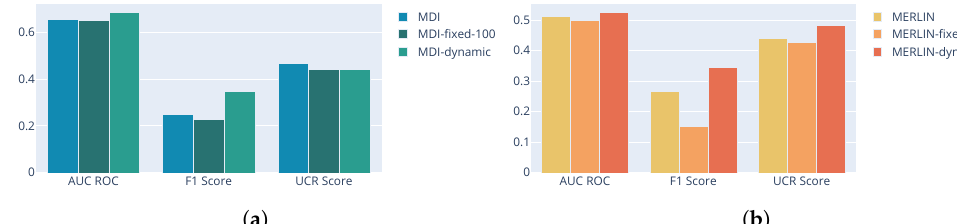
Figure 8. Results for different subsequence lengths for MDI (a) and MERLIN (b) . (a) The baseline results “MDI” are those from the main experiments using a subsequence length range of L min = 75 and L max = 125. The results labeled “MDI_fixed_100” were obtained using a fixed subsequence length of 100 time steps, while the results labeled “MDI_dynamic” were obtained by individually setting L min and L max to 75% and 125% of the true anomaly length, respectively, for each time series. (b) The baseline results “MERLIN” are those from the main experiments using a subsequence length range of L min = 75 and L max = 125. The results labeled “MERLIN_fixed_100” were obtained using a fixed subsequence length of 100 time steps, while the results labeled “MERLIN_dynamic” were obtained by individually setting L min and L max to 75% and 125% of the true anomaly length, respectively, for each time